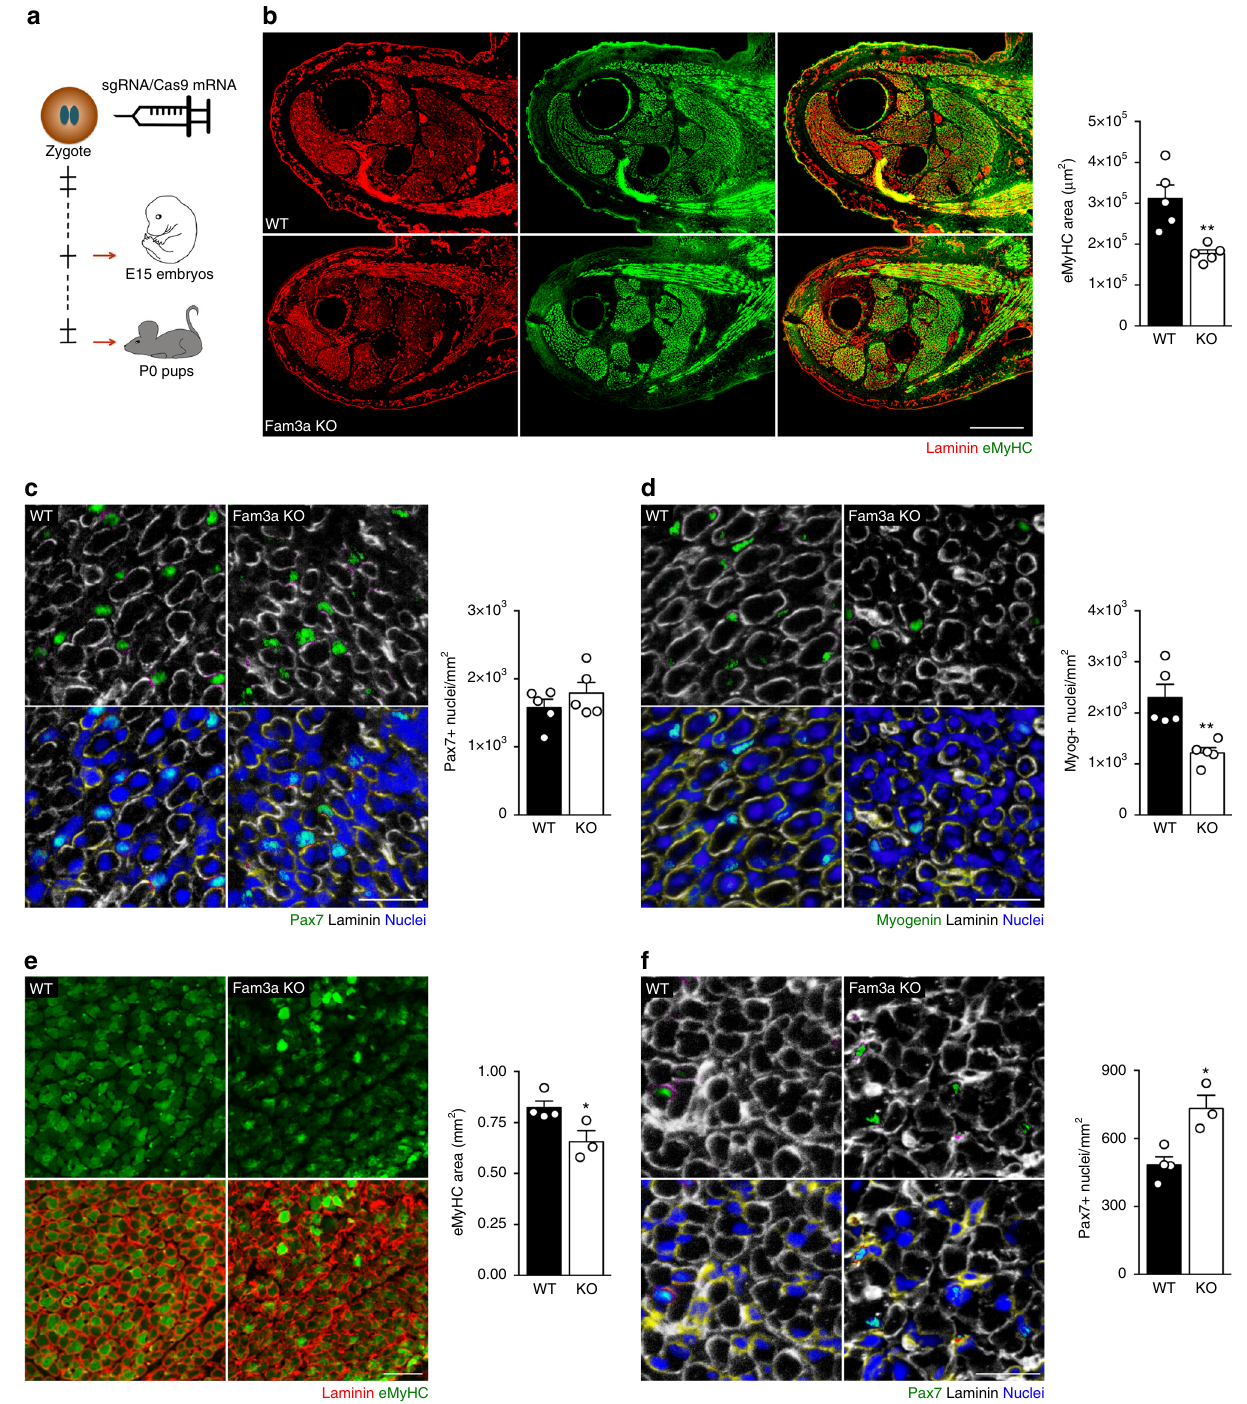
Fig. 4 Fam3a ablation compromises skeletal muscle development in vivo. a Scheme of the generation of the Fam3a knockout (KO) mouse model and the experimental design. b – d Immuno fl uorescence analysis of transversal sections of the hind limbs of wild-type (WT) and Fam3a KO E15 embryos. Quanti fi cation of the embryonic myosin heavy chain (eMyHC) area and the number of Pax7- and Myogenin-positive cells ( n = 5 embryos). Scale bars 300 and 30 μ m. e , f Immuno fl uorescence analysis of transversal sections of the hind limbs of WT and Fam3a KO P0 pups. Quanti fi cation of the eMyHC area and the number of Pax7-positive cells ( n = 3 – 4 pups). Scale bars 100 and 25 μ m. Data are represented as mean ±SEM (Student ’ s t test; * p < 0.05, ** p <